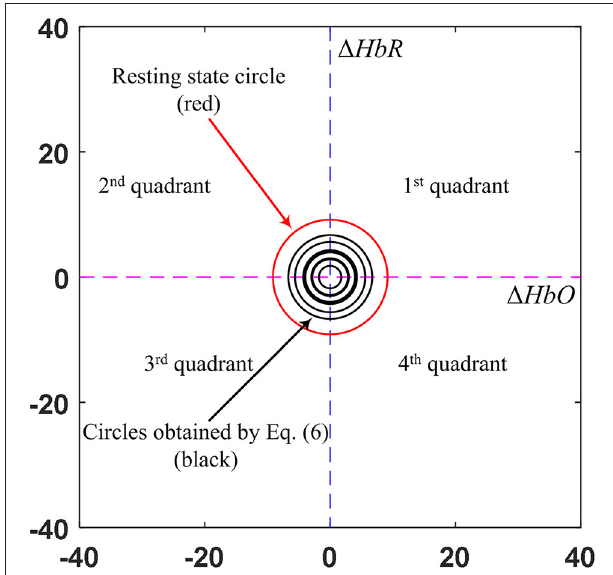
FIGURE 5 | Comparison of the circles (in black) obtained by the EEG activated window upon trials and the resting state threshold circle (in red) (Sub. 3).